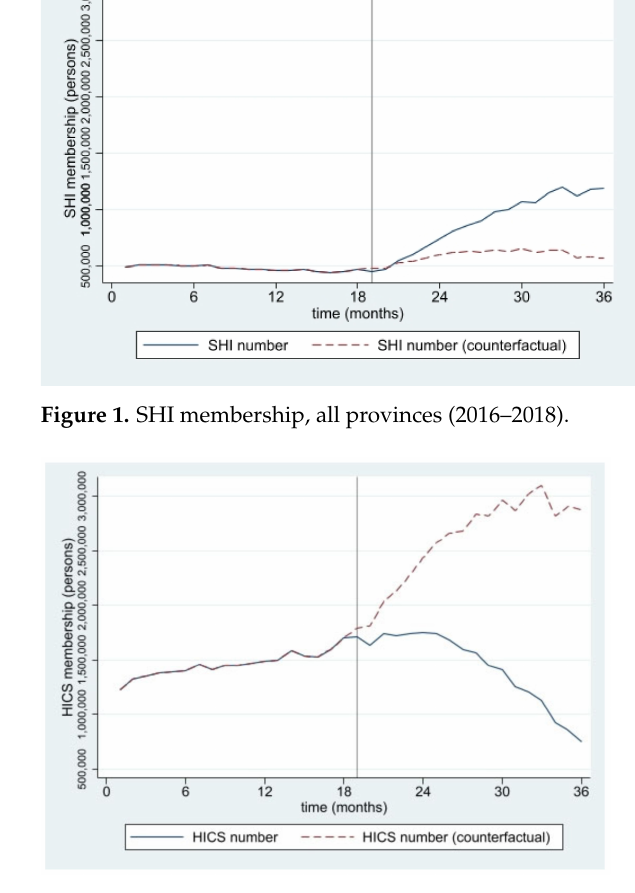
Figure 2. HICS membership, all provinces (2016–2018).